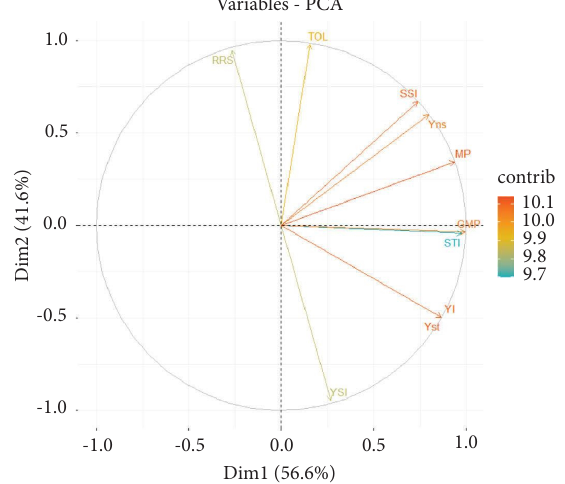
Figure 7: Phenotypic correlations between grain yield and stress screening indices among the 200 durum wheat genotypes evaluated under optimum and low N conditions at three